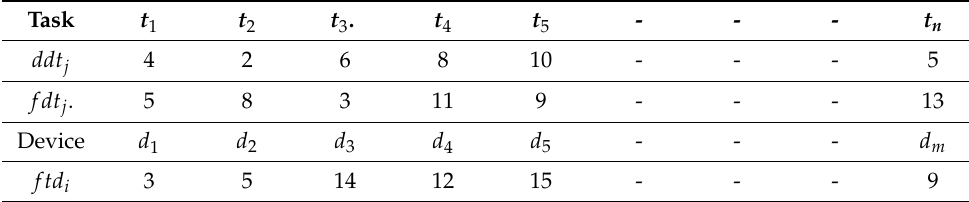
Table 5. Parameters of devices and